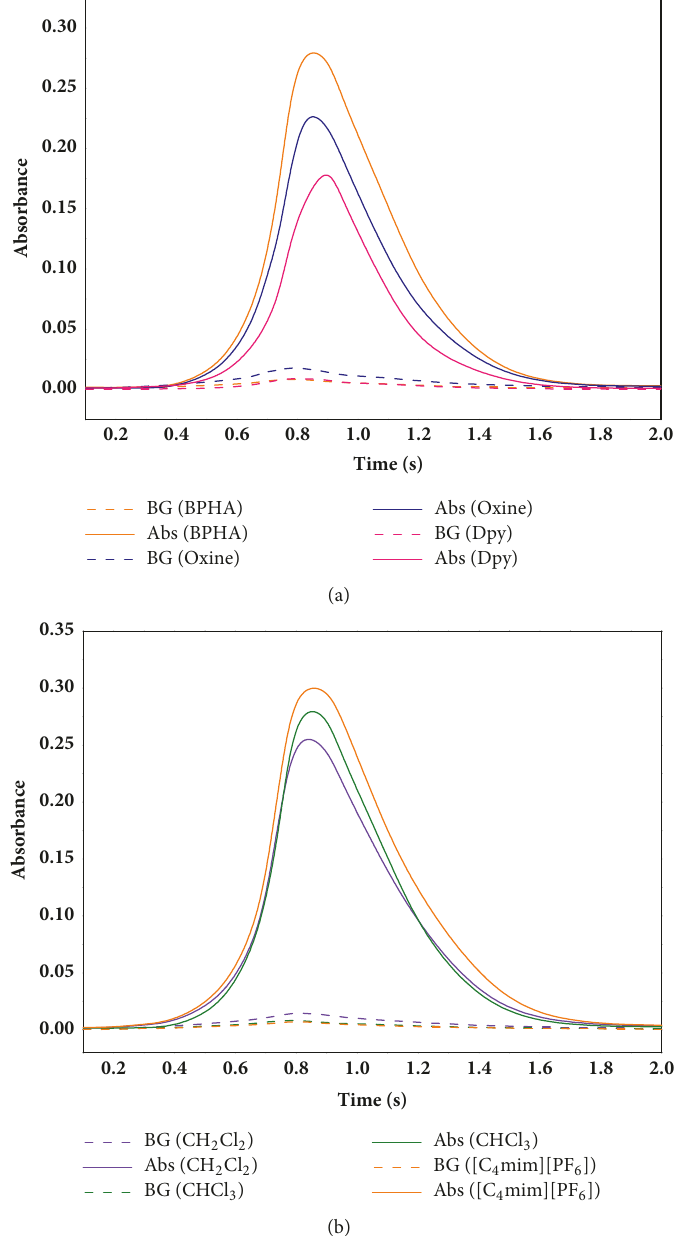
Figure 1: (a) The atomic absorbance of Sb (III) with different chelating agents such as BPHA, Oxine, and Dpy and their background absorbance. (b) The atomic absorbance of Sb (III) in different extraction solvents such as CH 2 Cl 2 , CHCl 3 , and [C 4 mim][PF 6 ] and their background absorbance; BG: background absorbance without Sb (III); Abs: